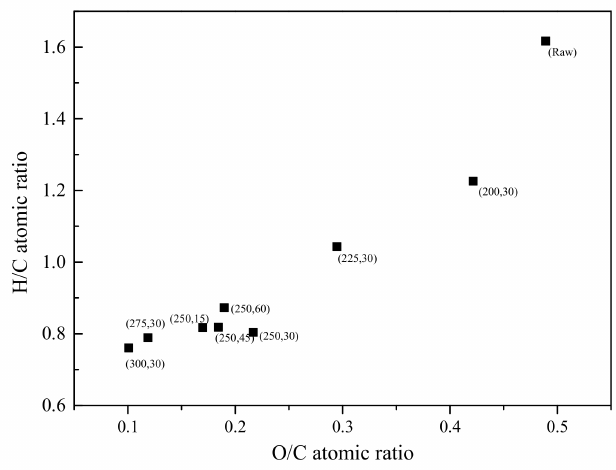
Figure 1. Van Krevelen diagram of torrefied cedar at temperature range of 200–300 ◦ C. Upon the torrefaction process, both hydrogen index and oxygen index decrease. The hydrophilic ability of biomass decreases as the result of decrease in O/C. The chemical stability is higher when both indexes decrease. The torrefied cedar is expected to be more resistant to degradation. The fuel with low H/C and low O/C, left region of the plot, correspond to high maturity fuel. The other index assessed the maturity of the biomass, aromaticity, could be calculated by traditional empirical formula according to V daf and C daf proposed by Van Krevelen [28] shown in Equation (1). The variation of aromaticity during torrefaction is shown in Figure